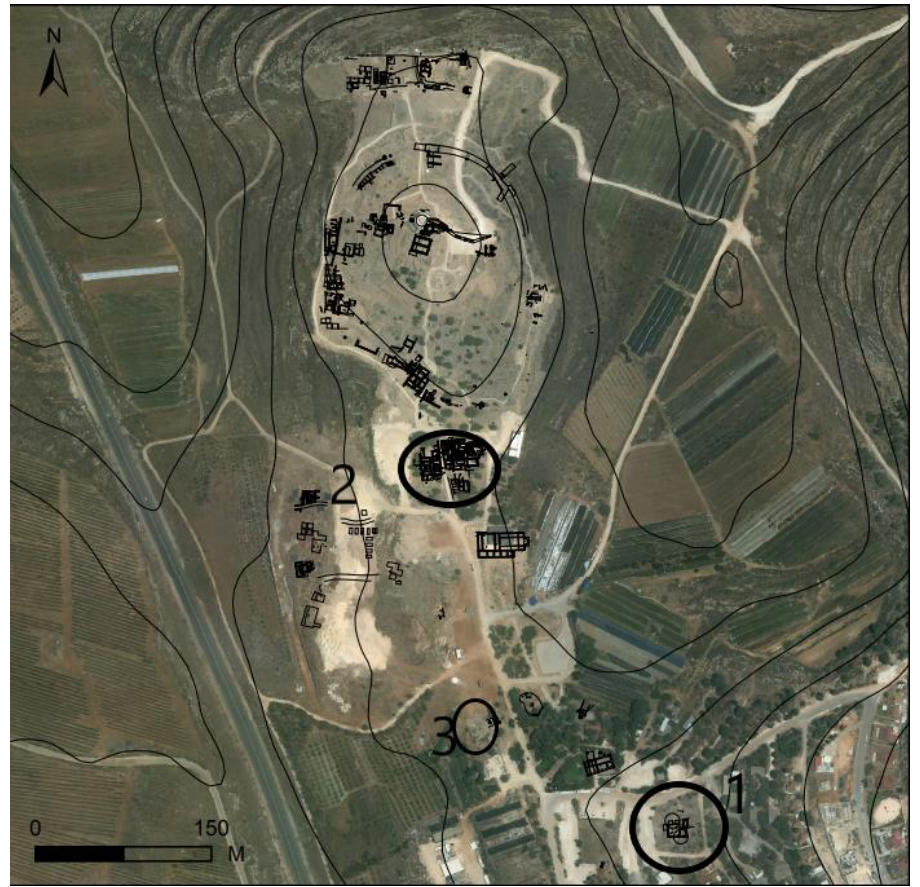
Figure 1. Site Plan: 1 : Jami ʿ al-Sitin. 2 : Jami ʿ al-Yatim 3 . open-air Weli , courtesy of Staff Officer for Archeology—Civil Administration of Judea and Samaria.